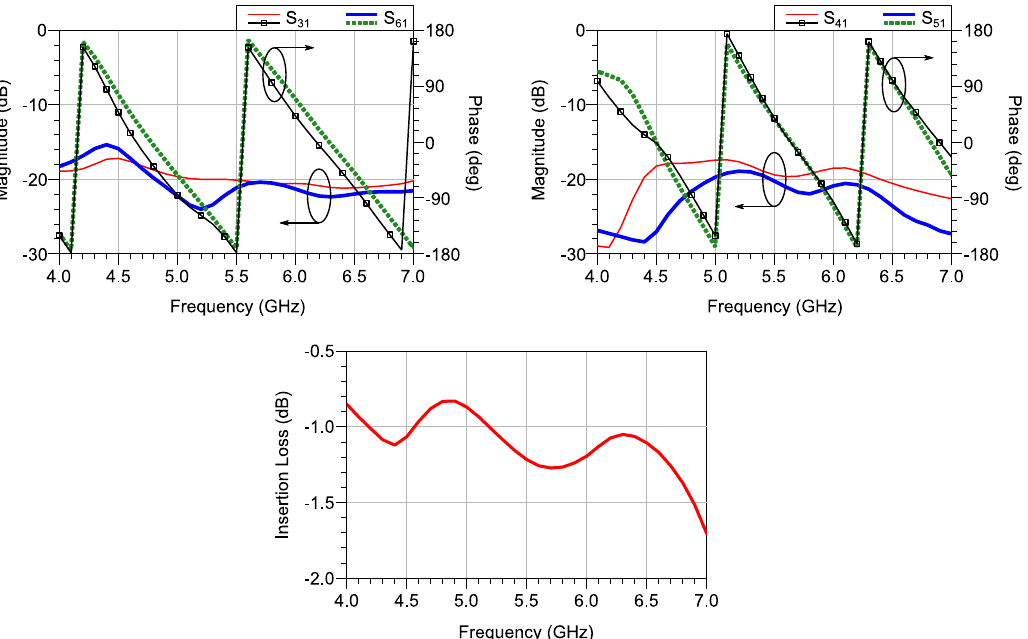
Figure 10. S-parameter measurements of the six-port junction. Upper row: the magnitude of S31 and S41 is reported with red solid line and the magnitude of S61 and S51 is reported with thick blue solid line. The phase of S31 and S41 is reported with green dotted line and the phase of S61 and S51 is shown with black square line. Lower row: insertion loss.